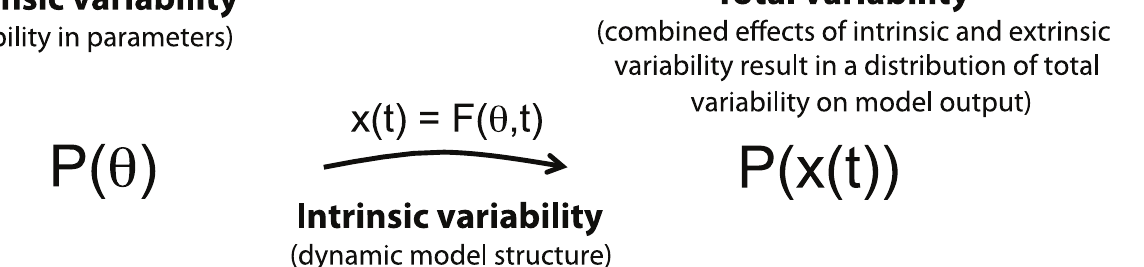
Figure 1. Framework overview. The framework combines intrinsic and extrinsic sources of variability and computes the total variability in model output. Extrinsic variability enters the model through variability in kinetic parameters and initial conditions. Intrinsic stochasticity is accounted for in the choice of a dynamical system; the master equation is the standard way of representing intrinsic variability, and due to its intractability we use an approximation of the master equation known as the V